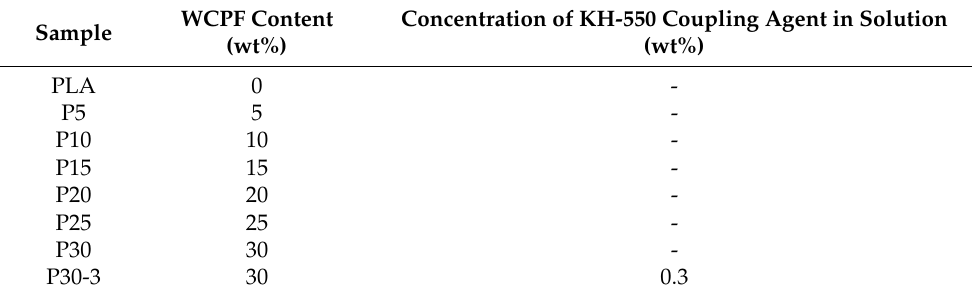
Table 1. The raw material ratio of the WCPF/PLA